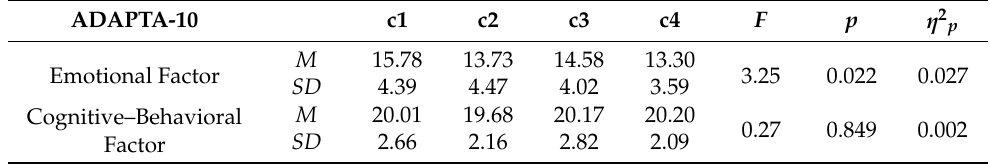
Table 4. Adaptation to change, by COVID-19 cluster. Descriptive